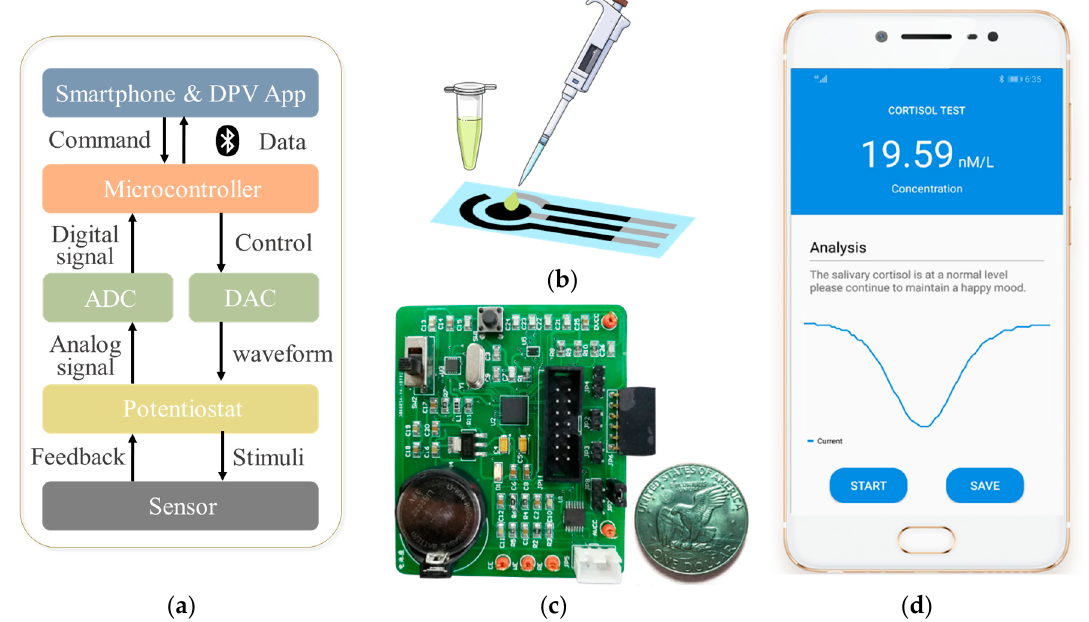
Figure 2. Structure of the miniaturized differential pulse voltammetry (DPV) system. ( a ) The diagram of the system, ( b ) EA/ CORT-Ab/ SH-PEG-COOH/ AuNPs/ MoS 2 / AuNPs biofunctionalized SPE /AuNPs/MoS 2 /AuNPs biofunctionalized SPE, ( c ) image of the designed printed circuit board (PCB), ( d ) the interface of the DPV detection application in the smartphone.